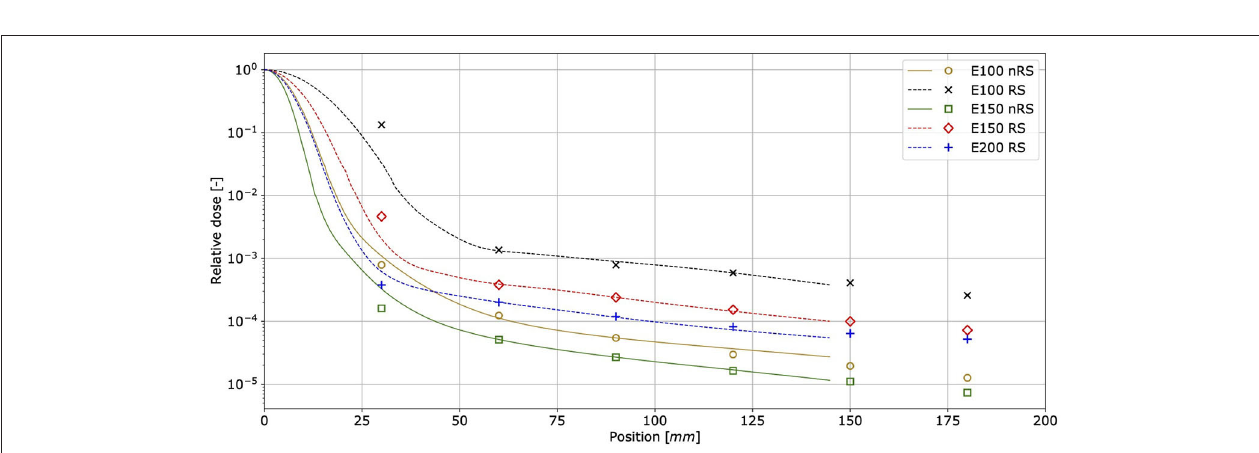
FIGURE 4 | Example of energy deposition spectrum for proton beam at the nominal energy E150 measured with M INI P IX T IMEPIX positioned at angle β = 57 ◦ before and after filtering for the particles incidence angle ( ± 3 ◦ ) as well as the one obtained from GATE /Geant4 MC simulation (left) . Energy deposition spectra after applying the cluster filtering procedure for nominal energy E150 and various β detector angles (middle) . Mean energy deposited in M INI P IX T IMEPIX was exposed to nominal proton energies E70, E100, E150, and E200 when positioned at various angles. The measurement results are compared to MC simulations and data calculated based on PSTAR stopping power tables (right)